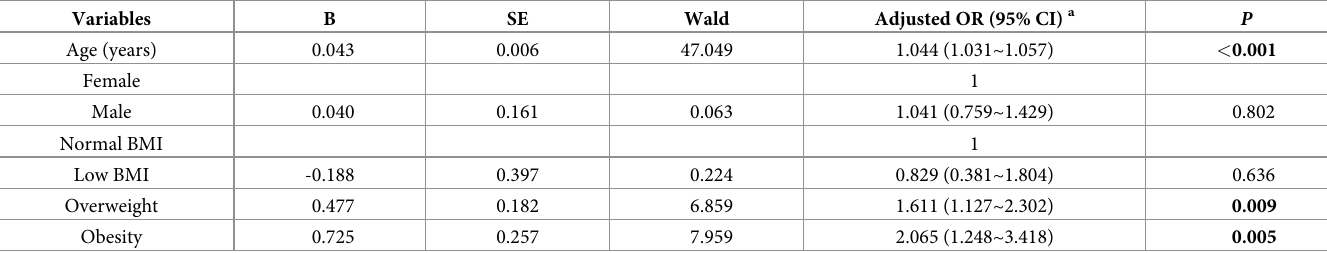
Genetic pattern analysis of NOS3 Loci with statistically significant differences in the allele frequency between hypertension and control groups ( P < 0.05) underwent genetic pattern analysis. Table 2. Essential hypertension risk factors in Guizhou populations (n =